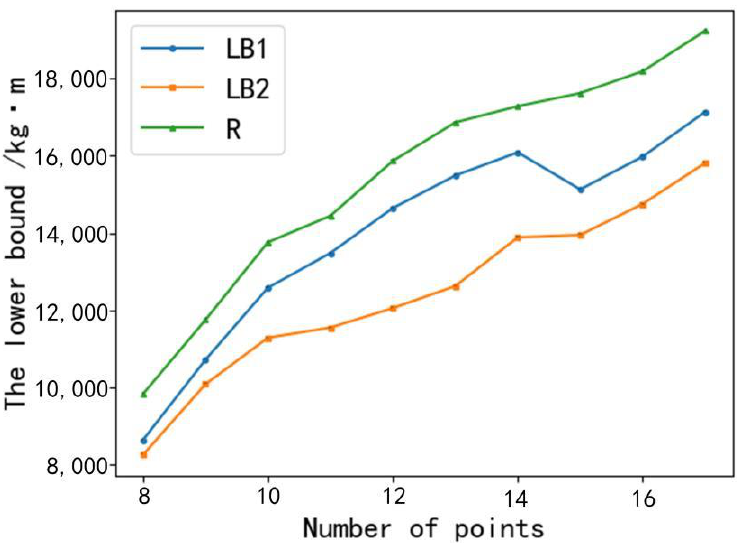
Figure 12. Comparison of algorithms for solving the lower bound of energy consumption.